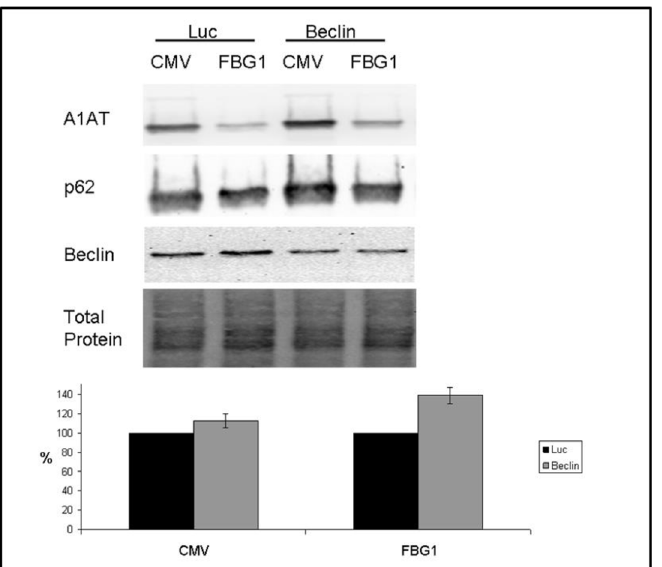
Fig 11. Inhibition of autophagy by Beclin1 siRNA inhibits FBG1-mediated clearance of A1AT-Z. A) Hepa1-6 cells stably selected after transfection with siLuciferase or siBeclin1. B) ImageJ analysis of A1AT-Z levels normalized to total protein. C) Table showing levels of normalized values for A1AT-Z and p62